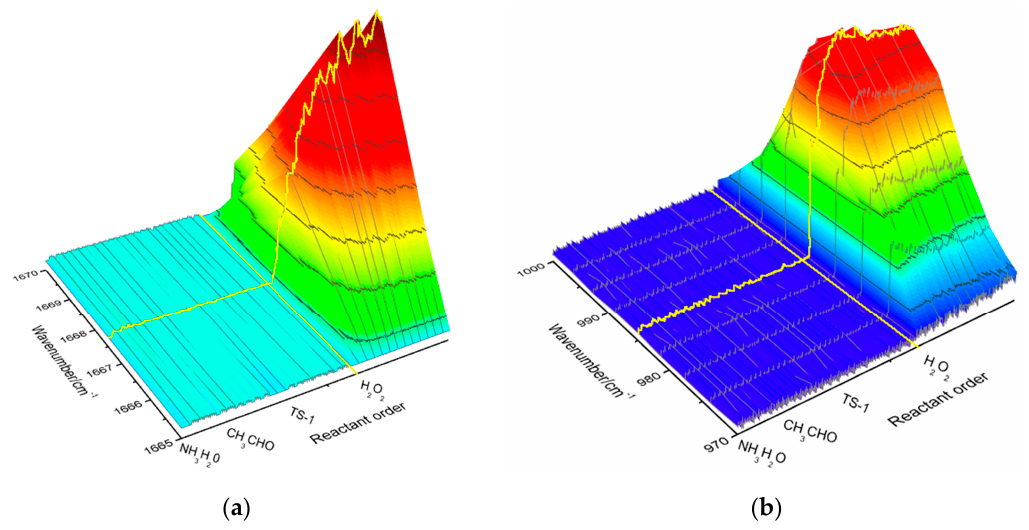
Figure 1. With the addition of reactants in order, ( a ) the peak value of 1667 cm − 1 and ( b ) the peak value of 985 cm − 1 changed. value of 985 cm ´ 1